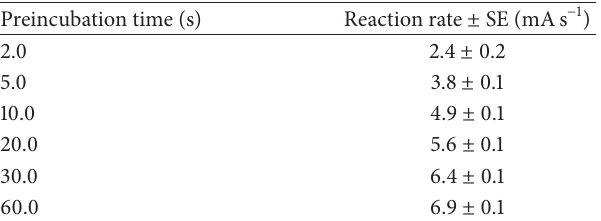
mA s −1 ) = −0.0569𝐶 2 + 0.8487𝐶 + 0.4622 , 𝑟 = 0.994